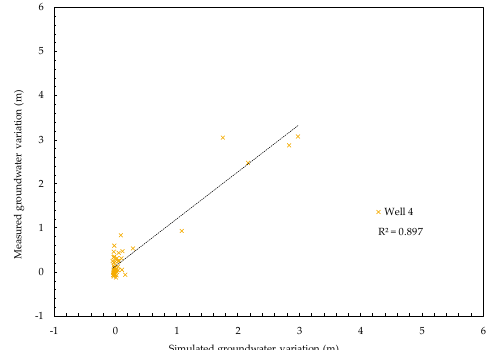
Figure 8. The model testing correlation relationship of Well 3.